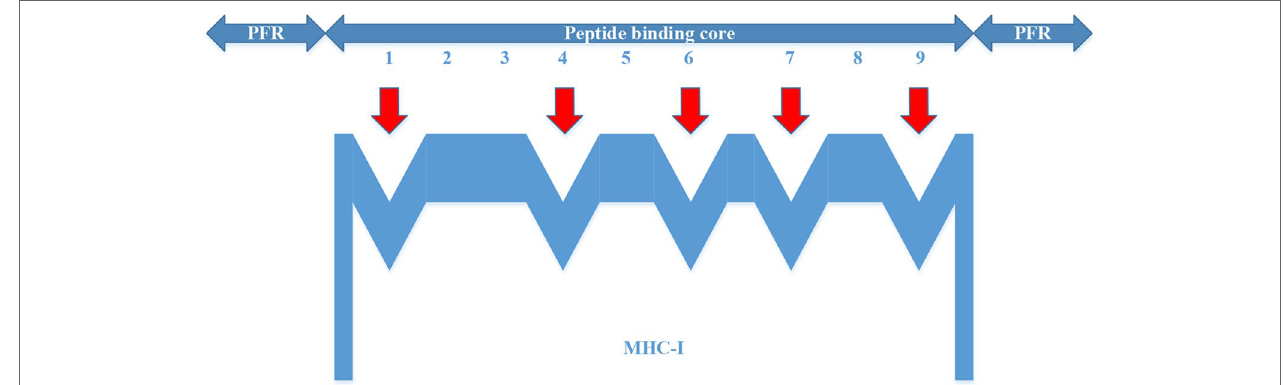
FIgURe 1 | Binding of major histocompatibility complex -I molecules to affinity peptides.